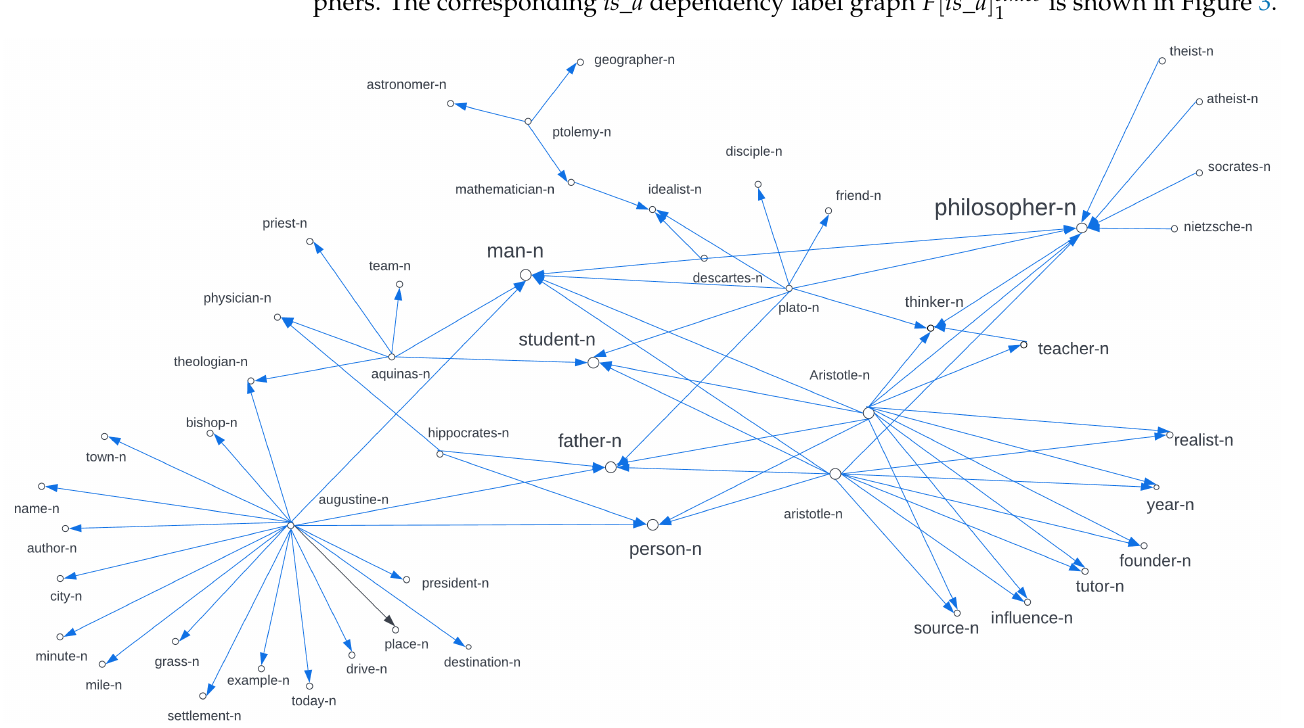
: is_a dependency label graph F [ is _ a ] ethics 1